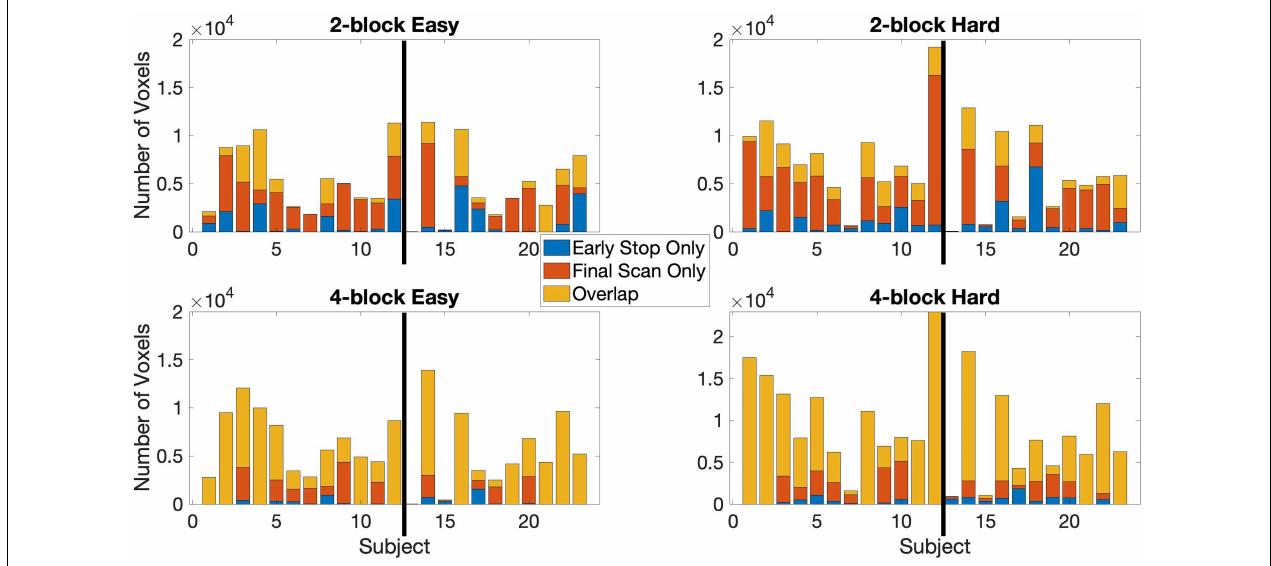
FIGURE 3 | The active voxel counts shown are for the voxels-in-common between the full duration scan and early stop scan and counts are for active voxels unique to either the final scan or early stop scan. Top row: 2-block easy and hard levels, bottom row: 4-block easy and hard levels. Maximum number of possible scans is 238, minimum is 78 scans for 2 blocks first stage of easy and hard stimulus administration or 154 scans for 4 blocks first stage of easy and hard. Information given for the point where 80% of voxels have been classified as either active or non-active. Results reported uses α E = 0.001, β E = 0.1, and z = 3.10 ( p < 0.001) at first scan after the first stage. The thick black line in each chart indicates the subject groups. Left of the black line (1–12) = control subjects, right of the black line (13–23) = EPT subjects.